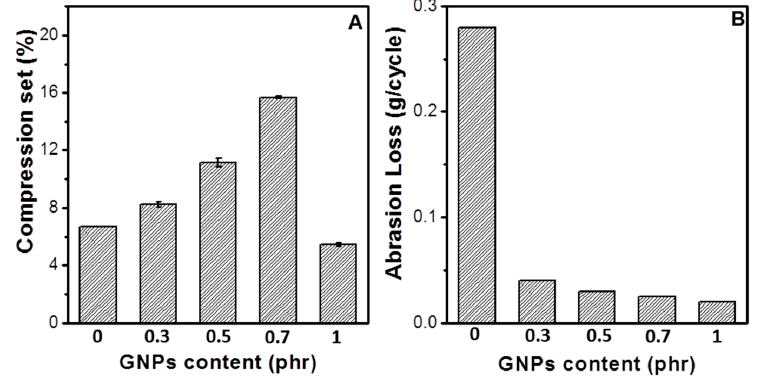
Figure 7. ( A ) Compression set and ( B ) abrasion loss of the control samples and the GNPs/natural rubber composites.